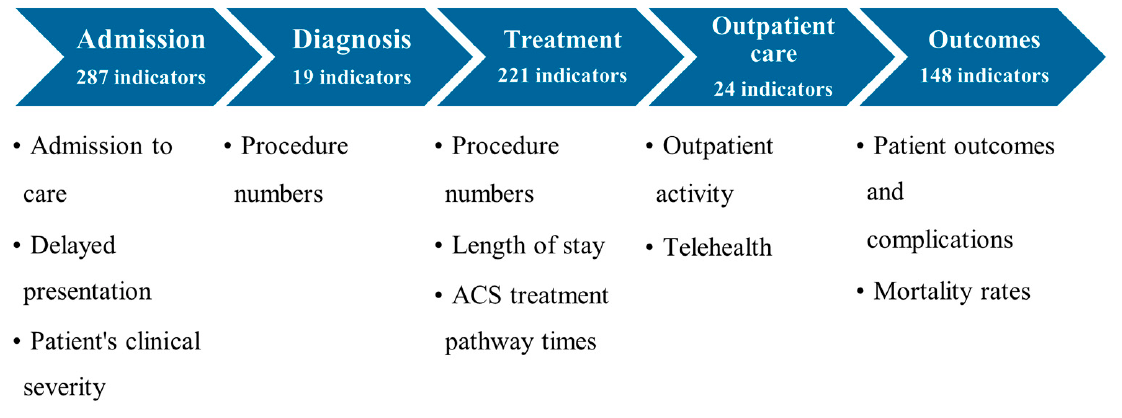
Figure 3. Categorization of indicators according to different phases of the hospital cardiac care pathway. Abbreviations: ACS—Acute Coronary Syndrome.